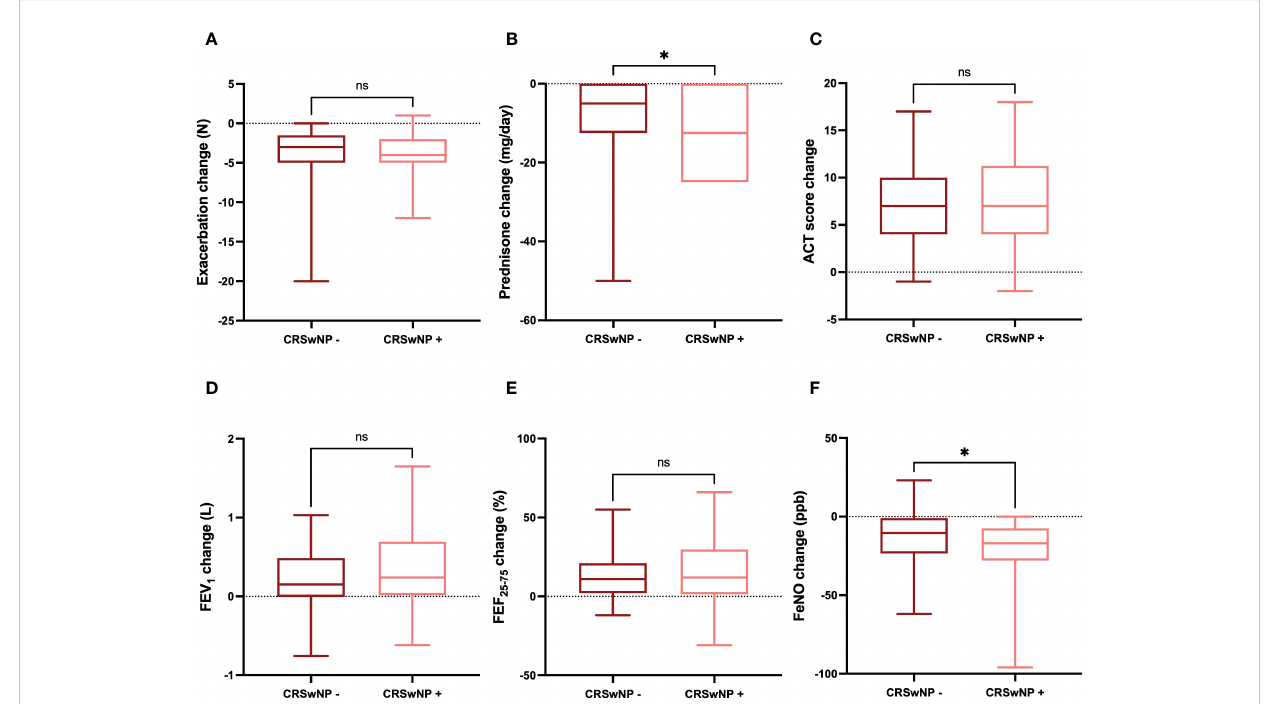
FIGURE 6 Comparative evaluation of dupilumab effects in relation to CRSwNP absence or presence, with regard to asthma exacerbations (A) , prednisone intake (B) , ACT score (C) , FEV1 (D) , FEF25-75 (E) , and FeNO levels (F) . Boxes display median values and IQR, and whiskers de fi ne maximum and minimum. ns, not signi fi cant; * p <